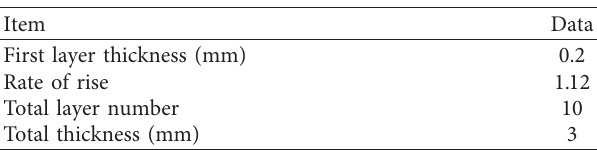
Figure 1: OSRVM cab mode and commercial vehicle cab: (a) OSRVM A with its cross section; (b) OSRVM B with its cross section; (c) OSRVM C with its cross section; (d) cab mode with the characteristic object; (e) the commercial vehicle with a special figure in real status; (f) the commercial vehicle with the trailer. Table 1: DES boundary layer.